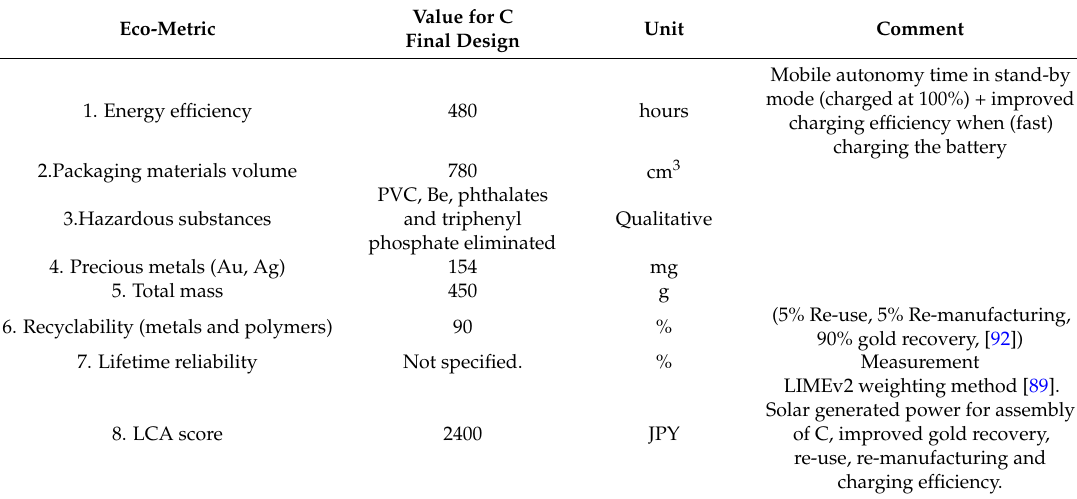
Table 3. Eco-metric values for Final design of C in Design Step